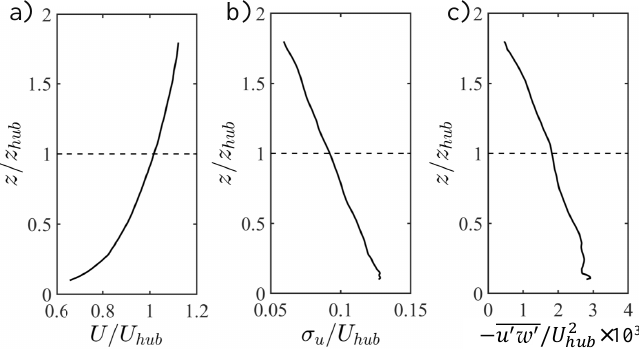
Figure 2. Characteristics of the incoming turbulent boundary layer. ( a ) Mean velocity U / U hub , ( b ) turbulence intensity I u = σ u / U hub , and ( c ) kinematic shear stress − u (cid:48) w (cid:48) / U 2 dashed line indicates the hub height location of the turbine